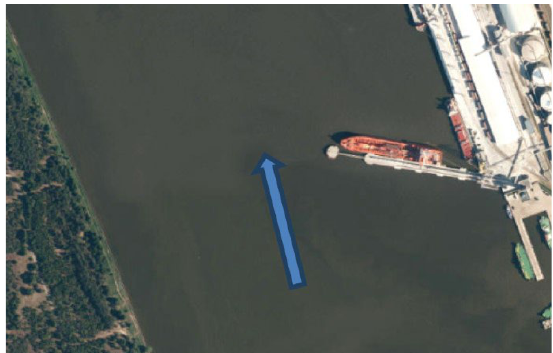
Fig. 5. Quay walls 71 and 72 located at an angle of 70° to the current at the Port of Klaipėda